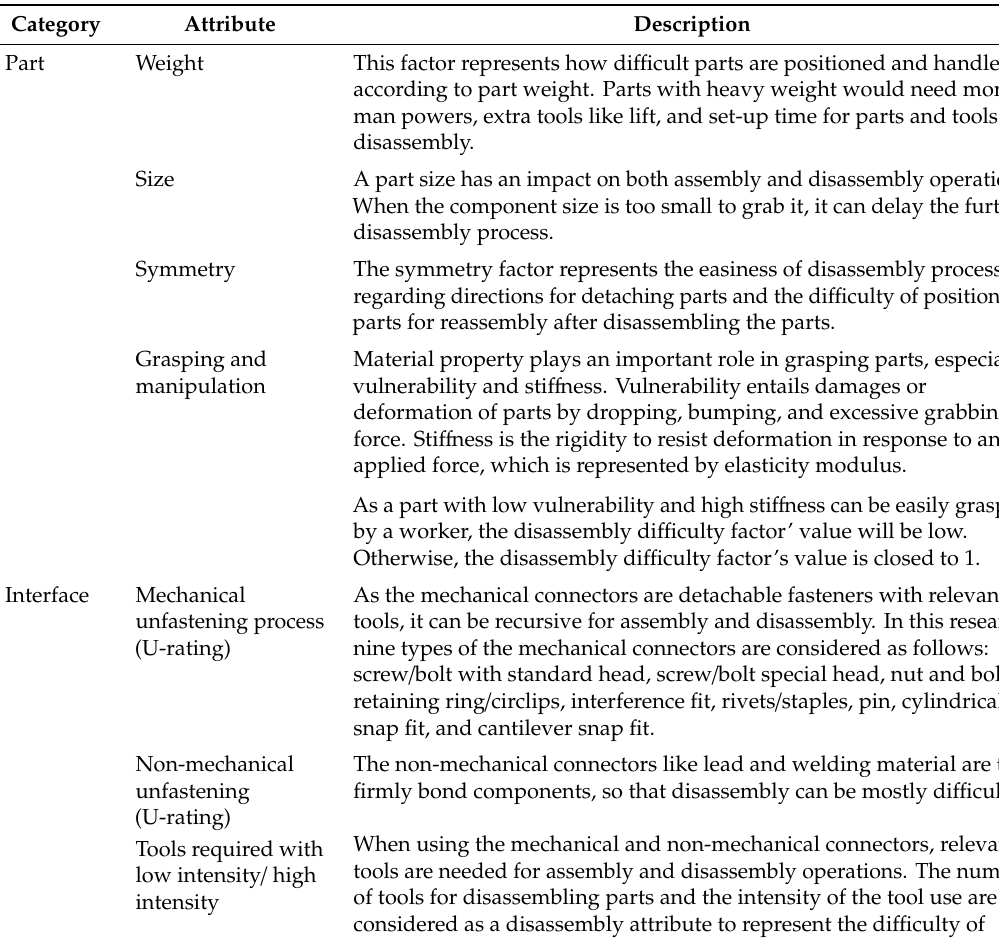
Table 1. Disassembly attributes for manual